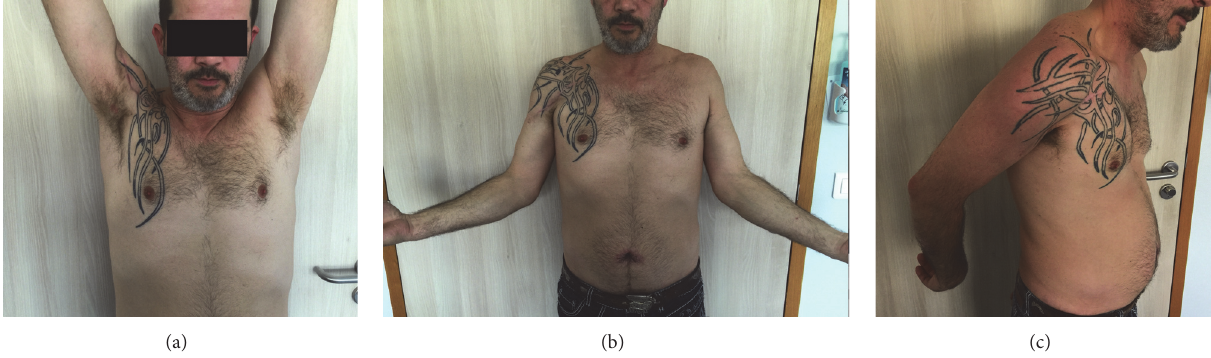
Figure 8: Complete range of motion in elevation (a) and in external rotation (b) and negative lift-off test